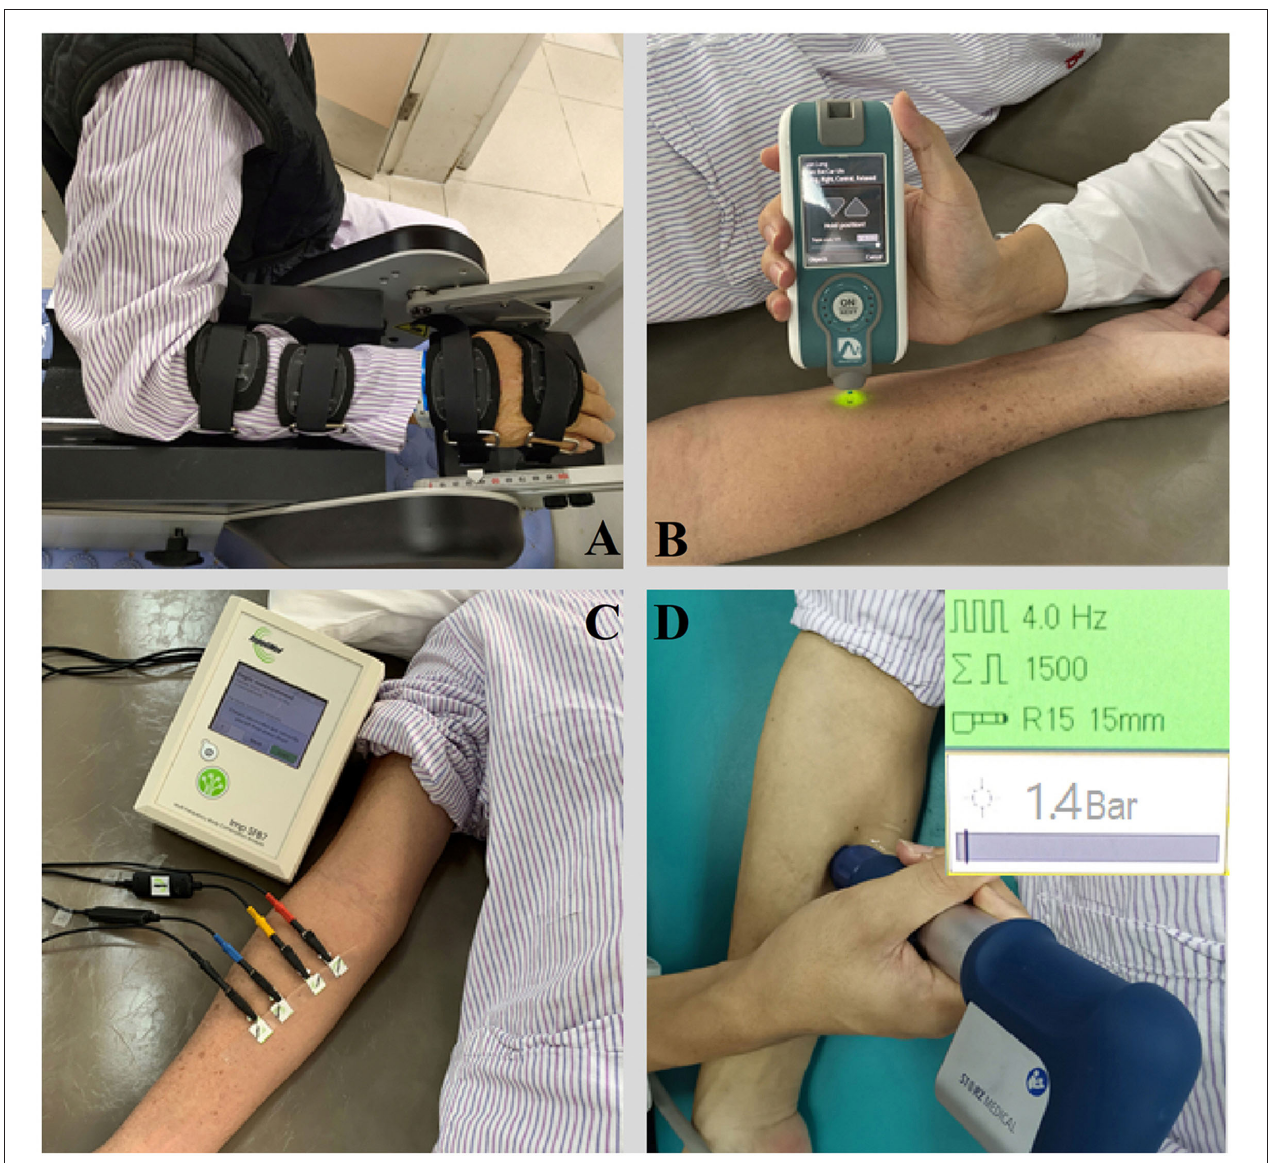
FIGURE 2 | The apparatus for measurement and therapy adopted in the study. (A) NeuroFlexor; (B) Myotonometer; (C) Electrical impedance myography; (D) Extracorporeal shock wave therapy.